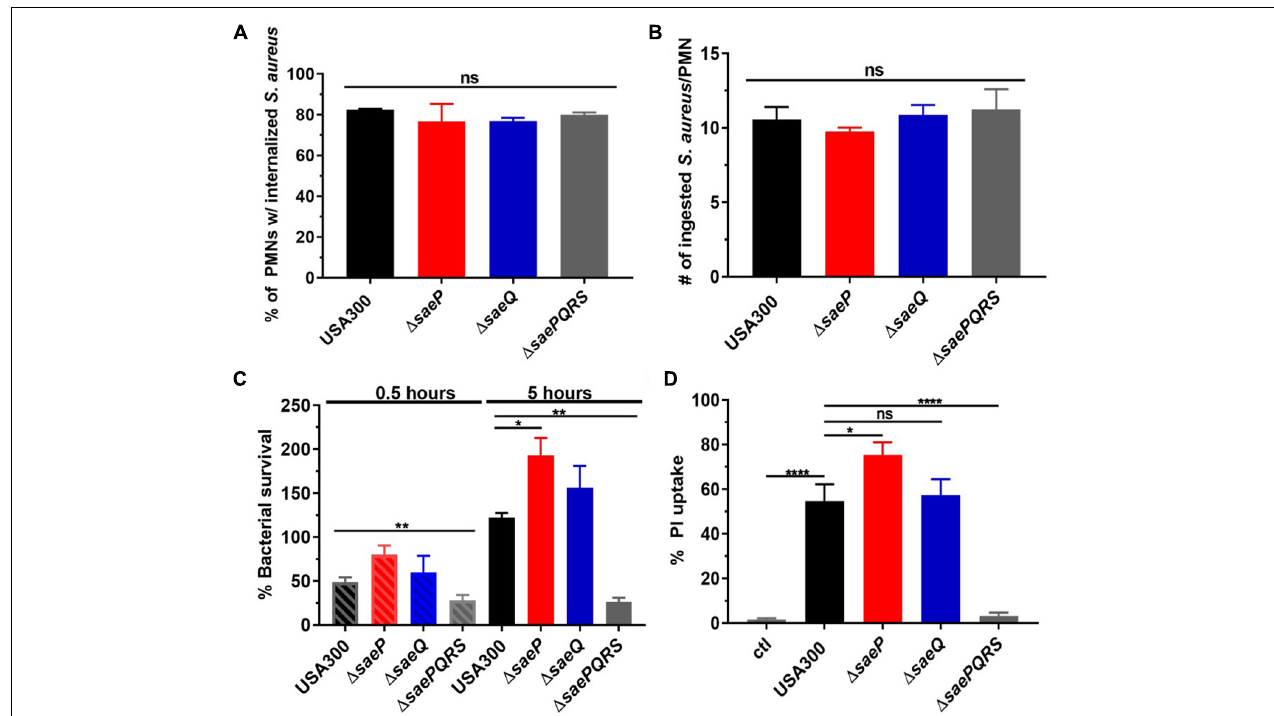
FIGURE 2 | Deletion of saeP significantly increases S. aureus survival and toxicity during neutrophil interaction. (A) Percent S. aureus ingested by neutrophils. Samples were collected on an Image Stream R (cid:13) Imaging Flow Cytometer and S. aureus internalization was analyzed using the IDEAS software R (cid:13) as described in Materials and Methods for three independent experiments. (B) Numbers of ingested S. aureus per PMN are shown. The average number of S. aureus detected to be ingested per PMN is ∼ 10 for all strains. Data are presented as the mean ± SEM of three independent experiments. (C) Percent survival for the indicated strains and timepoints is shown. Bacterial survival is significantly increased in USA300 (cid:49) saeP compared to USA300 at 5 h following phagocytosis. Survival was calculated with the following equation: (CFU + PMN at time n /CFU + PMN at time 0 ) × 100 (as in Voyich et al., 2005). Data are presented as the mean ± SEM of six independent experiments. At 0.5 h, USA300 (cid:49) saePQRS was significantly different from USA300 ** P ≤ 0.001 using one-way ANOVA with Tukey’s post-test. At 5 h, * P ≤ 0.05 and ** P ≤ 0.001 relative to USA300 using one-way ANOVA and Tukey’s post-test. (D) Supernatants from USA300 (cid:49) saeP cultures cause significantly more neutrophil plasma membrane damage compared to supernatants from USA300 cultures. S. aureus strains were grown to early stationary phase, supernatants harvested as described in Materials and Methods (diluted 1:10), and incubated with neutrophils for 1 h. Propidium iodide (PI) uptake was assessed by flow cytometry. Data are presented as the mean ± SEM of five independent experiments. * P ≤ 0.05, **** P ≤ 0.0001 using one-way ANOVA with Tukey’s post-test. ctl, neutrophil-only control. ns, not